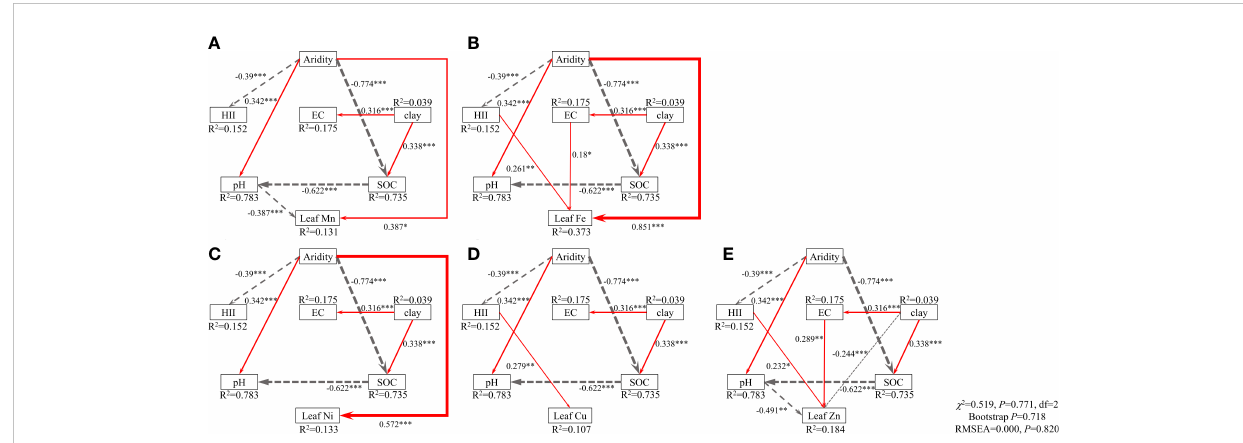
FIGURE 3 Effects of aridity, human impact index (HII), soil clay content, pH, electrical conductivity (EC) and organic carbon (SOC) on the concentrations of leaf Mn (A) , Fe (B) , Ni (C) , Cu (D) and Zn (E) . Numbers adjacent to arrows are standardized path coef fi cients (analogous to relative regression weights) and indicative of the effect size of the relationship. Continuous, red arrows indicate positive relationships, and dashed, grey arrows indicate negative relationships. The width of the arrows is proportional to the strength of path coef fi cients. R 2 denotes the proportion of variance explained. Goodness-of- fi t statistics for each model are shown in the lower right corner (df, degrees of freedom; RMSEA, root mean squared error of approximation), and all fi ve of them are same. The priori model was re fi ned by removing paths with non-signi fi cant relationships (see the priori model in Supplementary Figure 5). * P < 0.05, ** P < 0.01, *** P < 0.001.